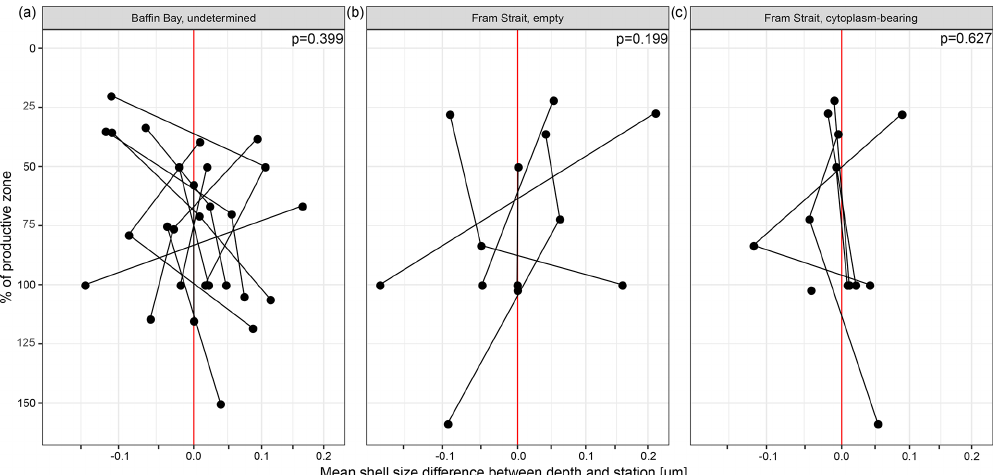
Figure 5. Mean of difference in mean shell size at the individual station and depth and the overall mean of the station, plotted against the percentage of the depth interval on the overall depth of the productive zone. 100% equals the total depth of the productive zone and 50% half of the depth of the productive zone. More than 100% is reached where the sampling interval ends below the BPZ. The plot is divided into different types of shells (undetermined, empty, cytoplasm-bearing) and the two regions from which size measurements are present (Baffin Bay, Fram Strait). Consider that the samples do not represent all samples from the region shown in Fig. 1 but only those from (a) MSM44 and MSM66 and (b, c) PS93.1. The red line indicates the position at which no difference between the mean of the depth and the overall station exists. Only the depth interval within the estimated productive zone of each station is shown. The p values show the effect of the increasing proportion of the productive zone on shell